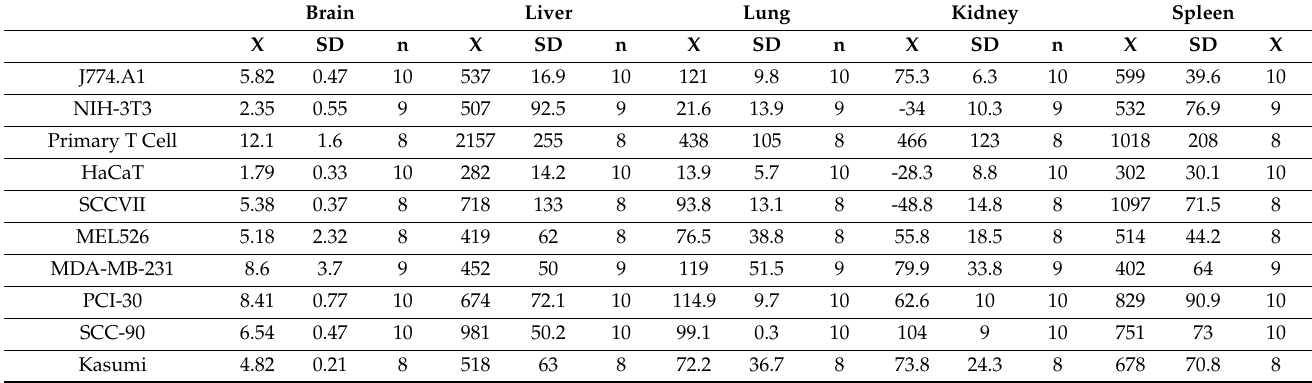
Table 2. Means (x), standard deviations (SD) and number per cell (n) for each exosome and tissue. Results are from control mice used in the WGA